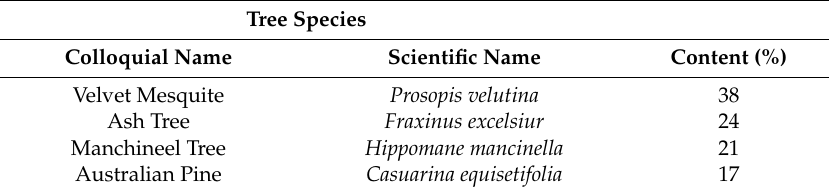
Table 2. Woody composition of sample 3, municipal